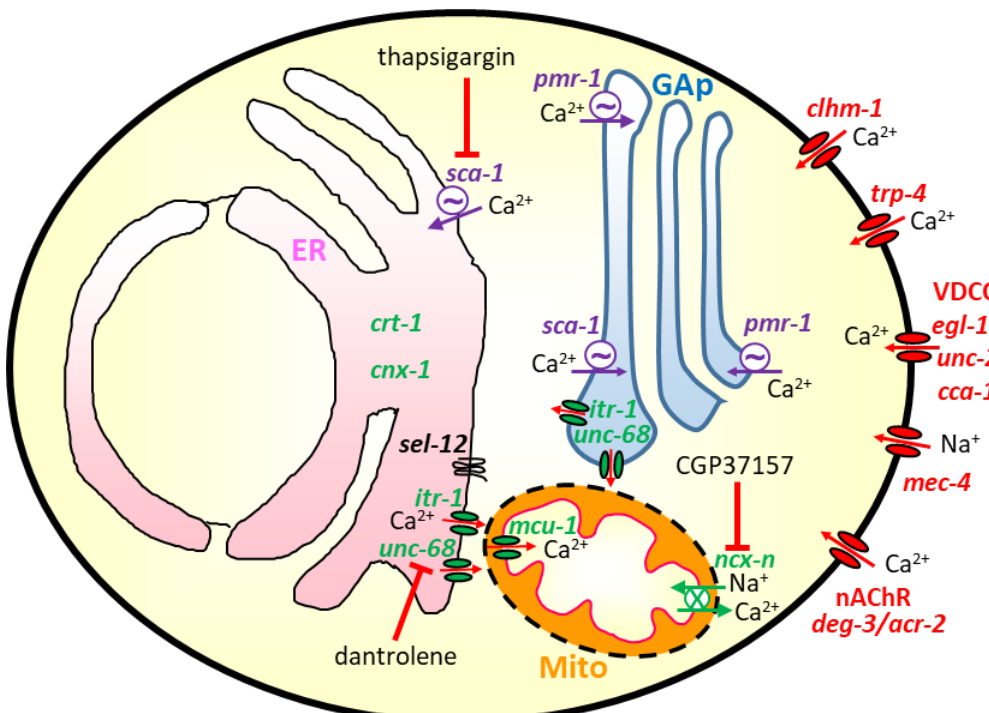
Figure 1. Scheme showing the Ca 2+ pathways that have been shown to be involved in the modulation of aging and neurodegeneration in C. elegans. In red: genes that have been mutated to induce neurodegeneration by increasing Ca 2+ entry from the extracellular medium; this includes Ca 2+ entry through the clhm-1 and trp-4 Ca 2+ channels, and through the nicotinic acetylcholine receptor nonselective cation channel with mutated deg-3 or acr-2 subunits. It also includes the mutated mec-4 mechanosensitive Na + channel, whose activation produces plasma membrane depolarization and activation of voltage-dependent Ca 2+ channels such as egl-19, unc-2, or cca-1 . In green: genes whose inactivation has been shown to produce protection in C. elegans models of neurodegeneration or increase longevity; this includes the Ca 2+ -binding ER chaperone proteins calreticulin ( crt-1 ) and calnexin ( cnx-1 ), the ER Ca 2+ channels IP 3 R ( itr-1 ) and RyR ( unc-68 ), and the mitochondrial Ca 2+ transporters, both the mitochondrial Ca 2+ uniporter ( mcu-1 ) and the mitochondrial Na + /Ca 2+ exchanger (gene not yet identified within the large C. elegans ncx-1 to 10 family [65]). Finally, in purple: genes whose modulation has produced in some cases neurotoxicity and in others neuroprotection; this group includes the SERCA Ca 2+ pump ( sca-1 ) and the Ca 2+ pump of the secretory pathway ( pmr-1 , placed in the membrane of the Golgi apparatus (GAp)). The figure also shows some of the most used inhibitors of Ca 2+ pathways, thapsigargin for the SERCA pump, dantrolene for the RyR and CGP37157 for the mitochondrial Na + /Ca 2+ exchanger. The presenilin homologue sel-12 gene is depicted in the ER membrane, close to the ER-mitochondria contacts.